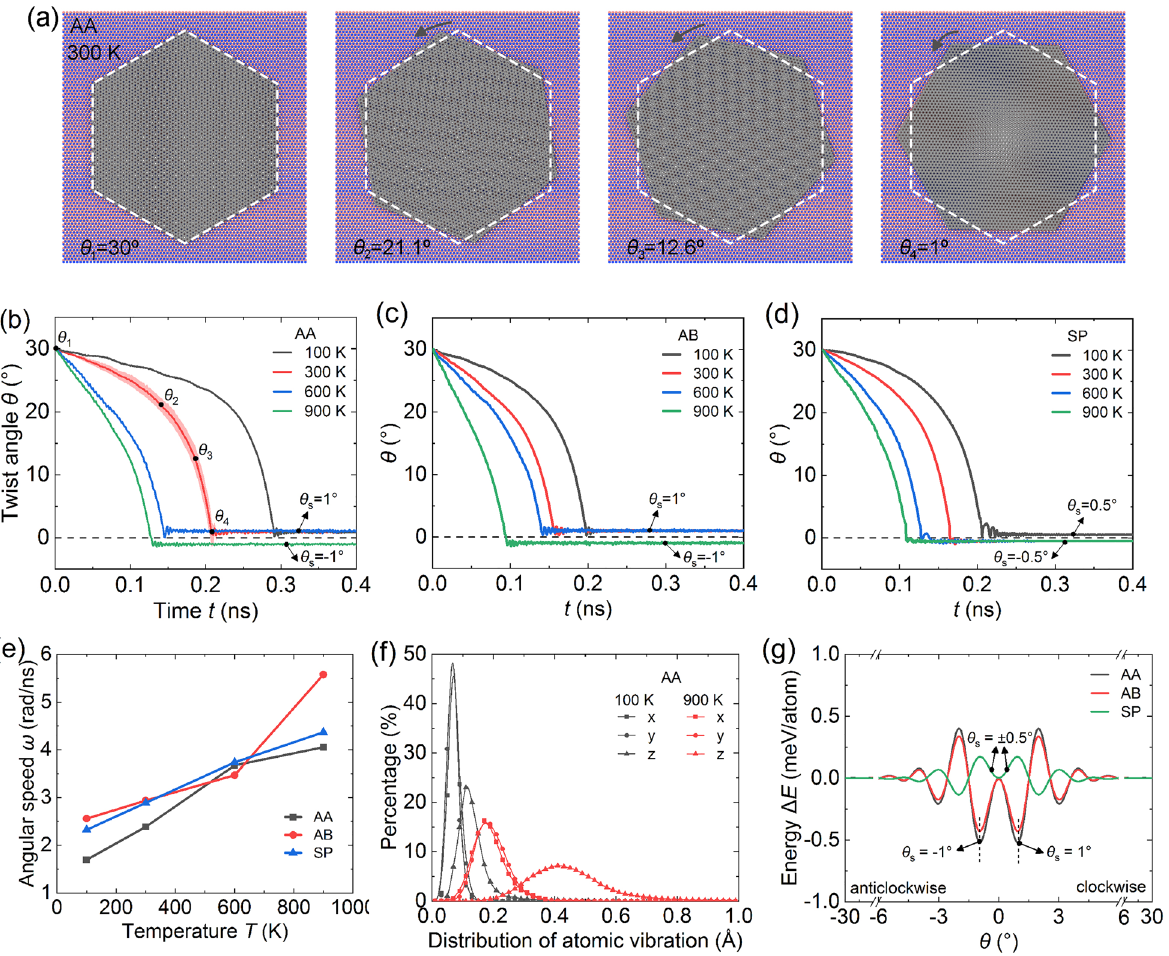
Figure 2. Temperature-modulated dynamic twisting of the graphene flake on monolayer h -BN. ( a ) Typical twist at 300 K. ( b – d ) Twist angles θ vary with time for AA, AB, and SP modes at series temperature. Each curve has only slight thermal fluctuations, as demonstrated by the red error band for AA at 300 K. ( e ) Average angular speed ω as a function of temperature. ω is calculated as the θ difference from the initial value to the first local minimum divided by the time. ( f ) The elevated temperature (100 to 900 K) mainly enhances the out-of- plane vibration (0.1 to 0.4 Å) of atoms in the flake. Each data point represents an interval width of 0.02 Å. ( g ) Interlayer energy versus θ at 0 K. θ s in ( b – d ) approaches the local minima of curves in ( g